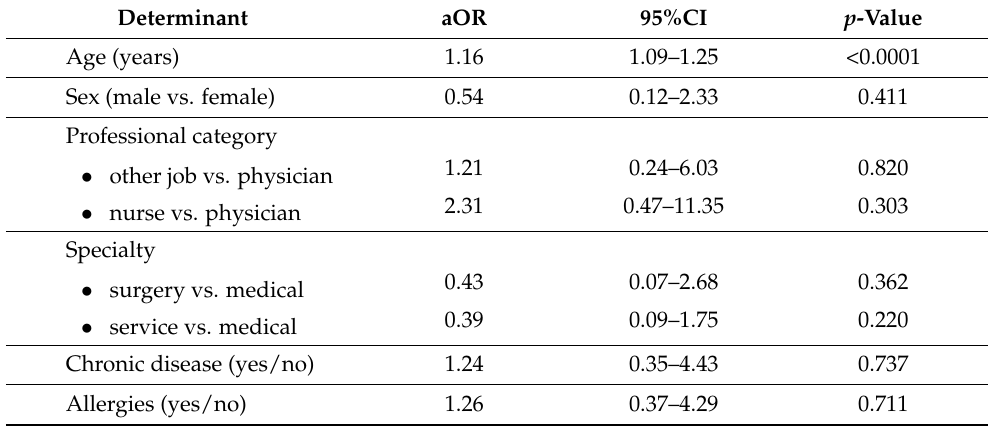
Table 5. Analysis of determinants of vaccination refusal in a multivariate logistic regression